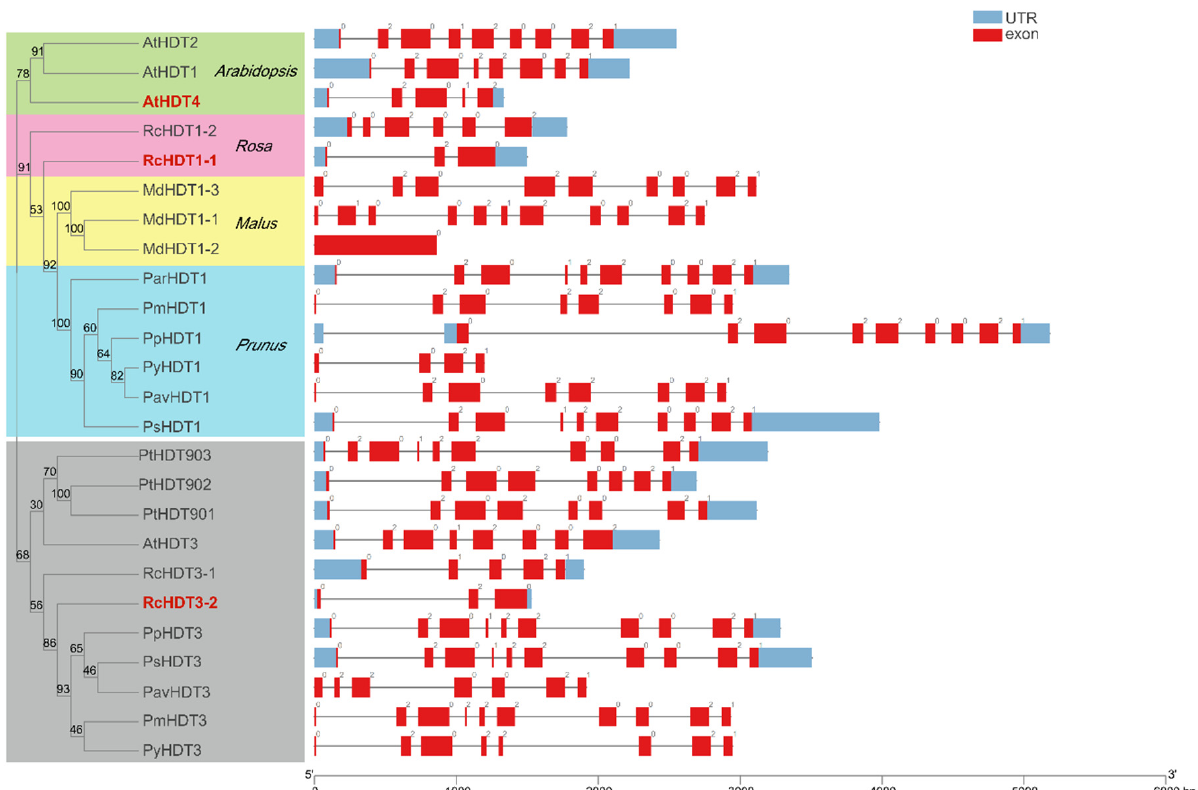
Figure 3. Phylogenetic tree and exons distribution of HD2 family genes. The unrooted maximum likelihood tree was constructed by IQtree 2.1.3 using complete protein sequences with 1000 bootstraps. The red members represent HD2s that do not contain the zinc-finger domain.